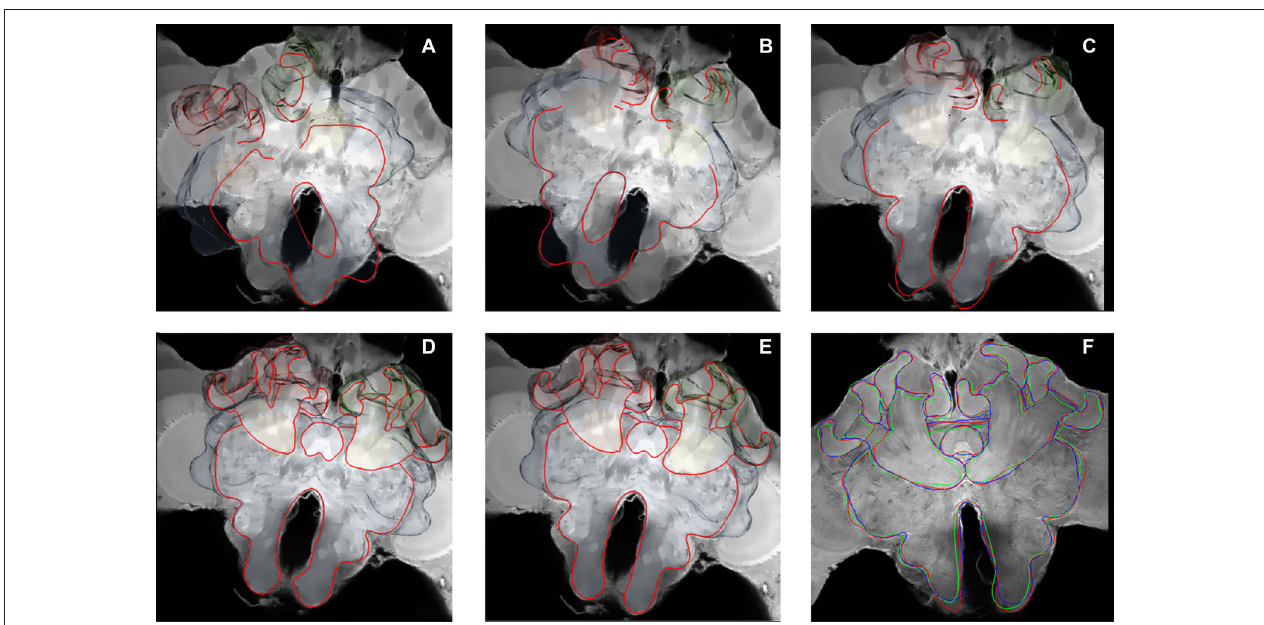
Figure 6 | evaluation of the statistical shape model (SSM) and the displacement algorithm. The auto-segmentation process illustrated by a leave-all-in segmentation of preparation LY-12 (Lucifer yellow background stain) with the SSM. (A) Initial position of the average shape of the lateral mushroom body. (B, C) Result of the initial global positioning of a simplified